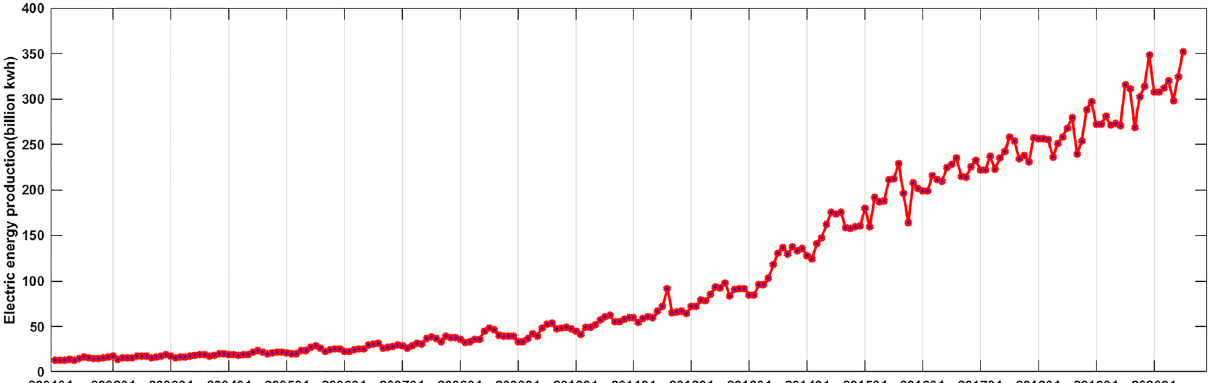
Figure 3. Time series of electric energy production in Xinjiang from January 2001 to July 2020 (since the x-axis length is limited, only the January location of each year is marked in the figure).